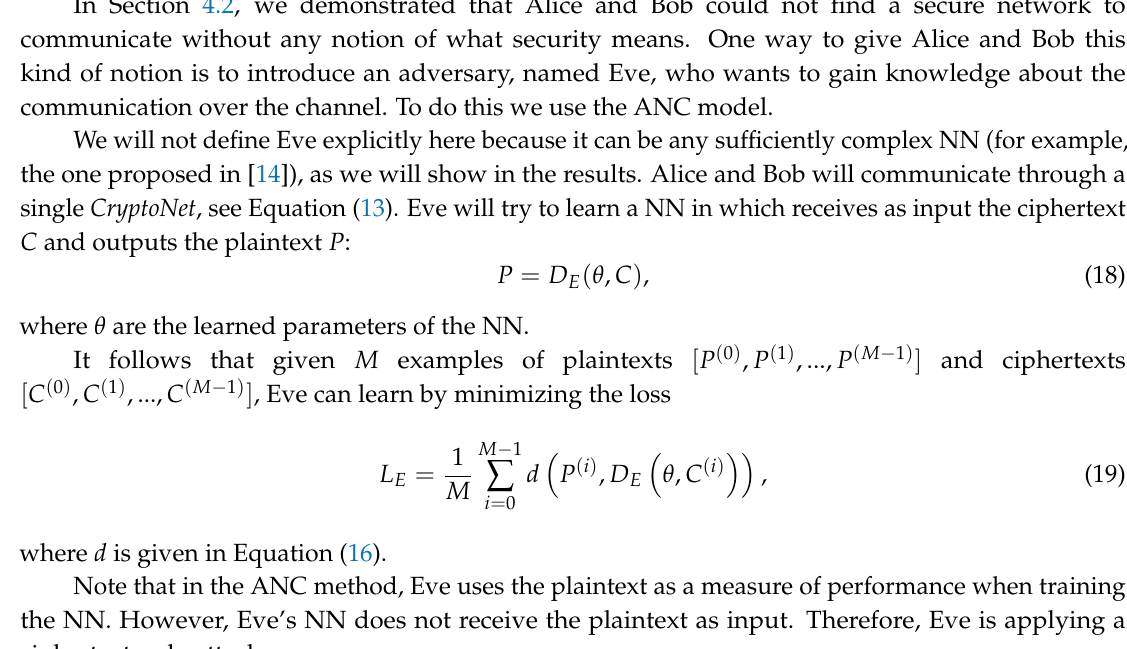
Table 1. 10 networks were learned and tested using Algorithm 1 for each key size. All the trials were successful since Alice and Bob were able to communicate without errors. However, all the trials resulted in an insecure algorithm. Successful Secure Algorithm Size of Key Number of Trials Communications Learned (OTP) 4-bit 10 10 0 8-bit